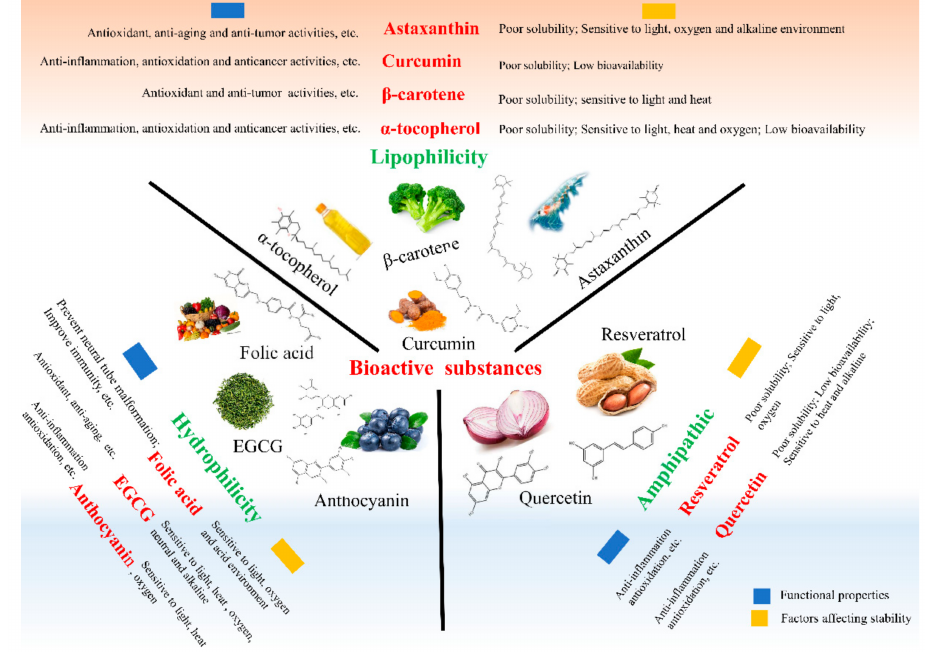
Figure 3. Schematic diagram of factors affecting the stability of bioactive